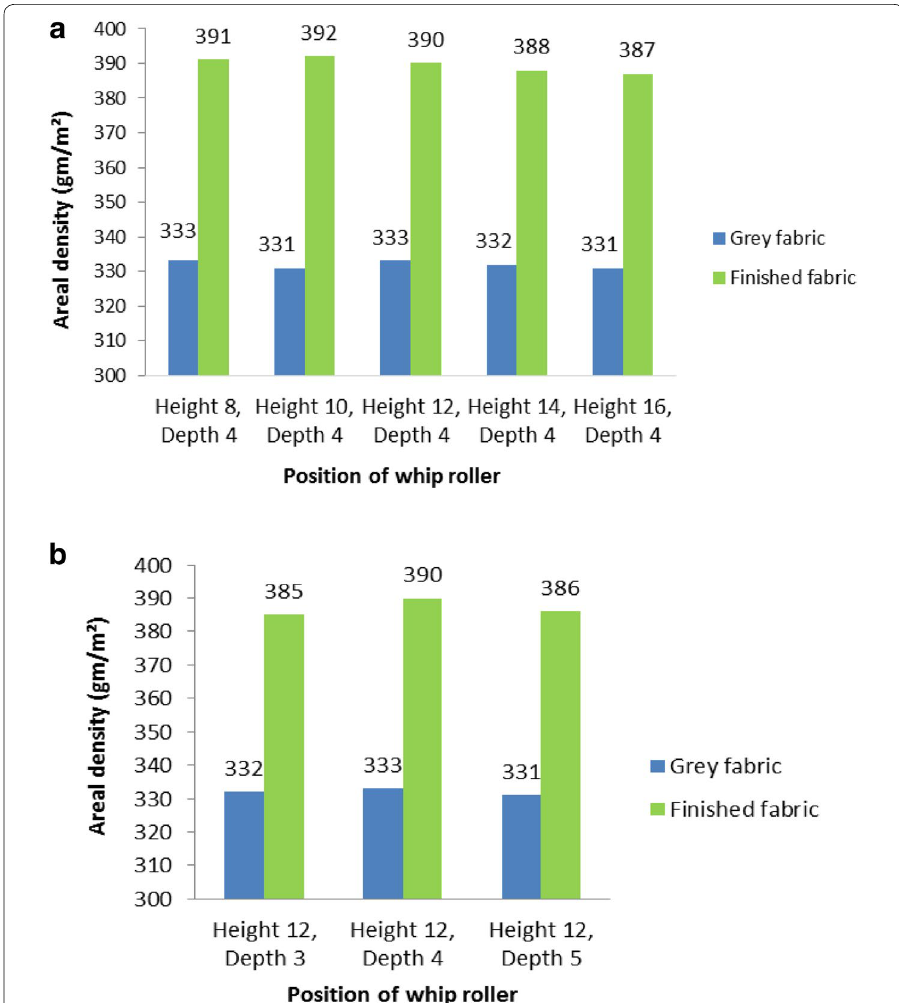
Fig. 3 a Areal density at variable height and constant depth of whip roller. b Areal density at constant height and variable depth of whip